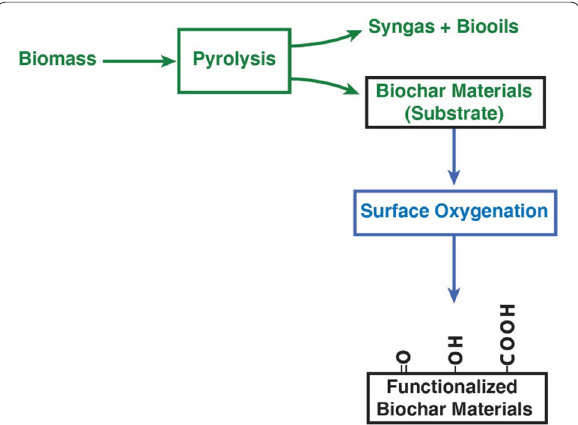
Fig. 1 Process schematic showing postproduction surface-oxy- genation treatment (e.g., ozonization) to create oxygen-containing functional groups on the biochar